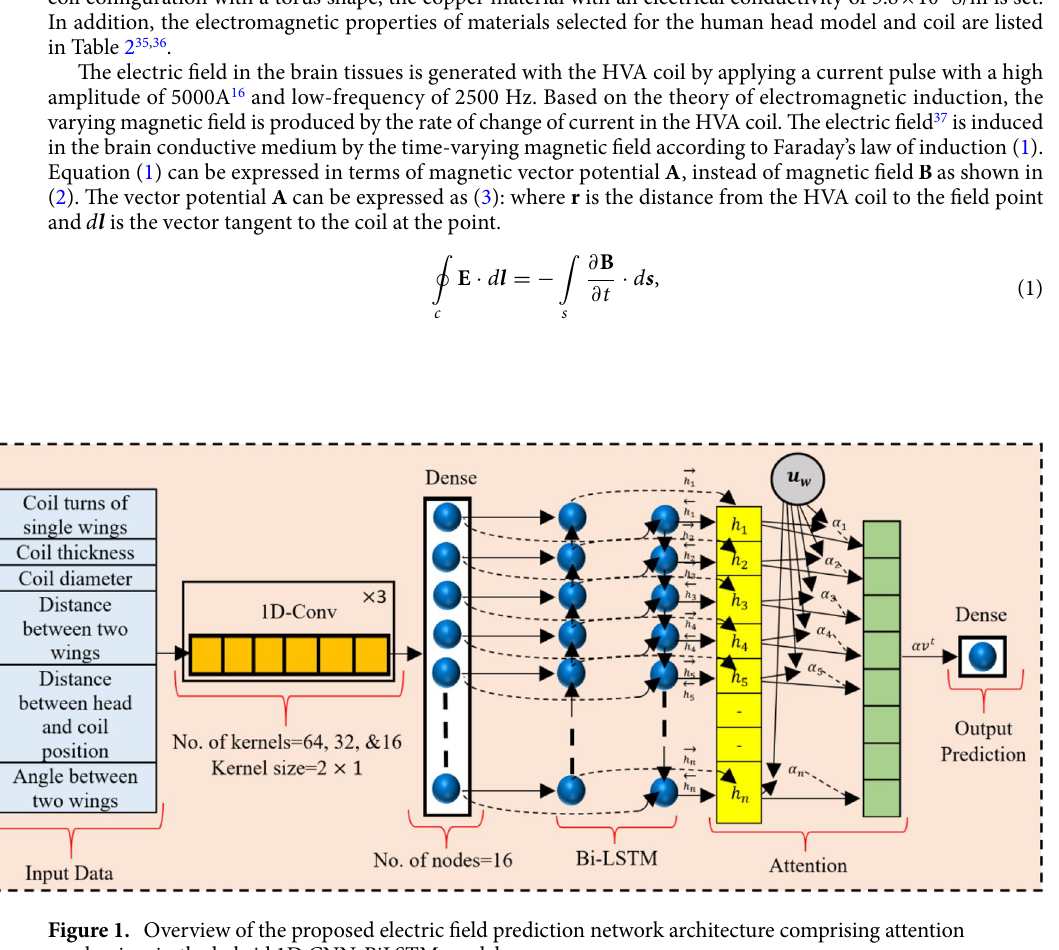
Figure 1. Overview of the proposed electric field prediction network architecture comprising attention mechanism in the hybrid 1D CNN-BiLSTM